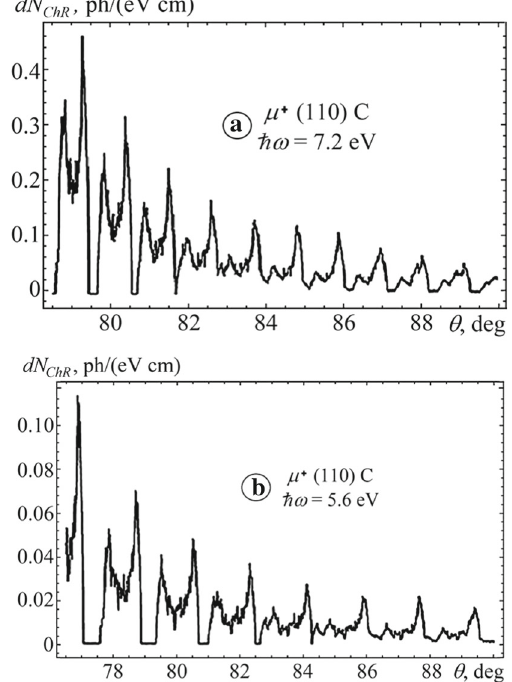
Fig. 6 ChCR angular distributions for two chosen energies 7 . 2 eV and 5 . 6 eV emitted by 10 GeV μ + channeled in C crystal (for angles greater than θ > 73 ◦